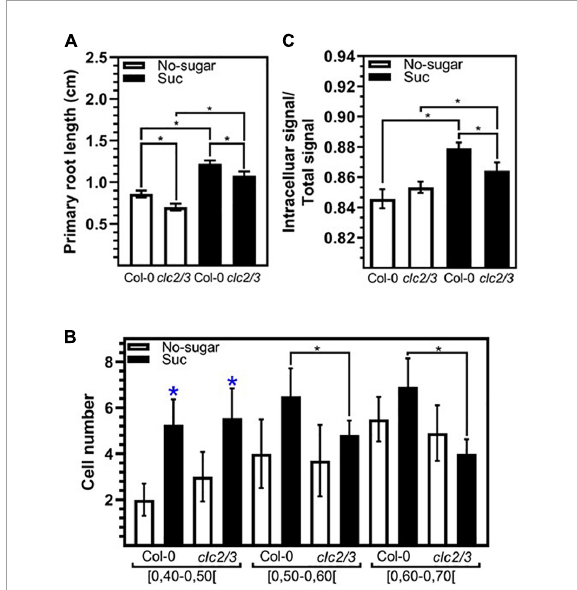
FIGURE5 The function of CLC2 and CLC3 are required for sucrose induced endocytosis and cell elongation. Arabidopsis wild-type (Col-0) and clc2-1 clc3-1 ( clc2/3 ) seedlings were sown on sugar-free (No-sugar) or 60 mM sucrose-supplemented (Suc) solid medium and grown for 7 days. (A) Primary root length of seedlings was measured in n ≥ 20 seedlings per replicate. (B) Cell height and width were measured for epidermal cells on the meristematic zone (ratio height/width ≤ 1) of the seedling primary root. The number of cells that display a range of a cell elongation index is shown. n ≥ 15 seedlings were scored in either condition. (C) Endocytosis of FM4-64 was evaluated by confocal imaging of epidermal cells after 15 min of FM4-64 plasma membrane labeling. About 15 seedlings were evaluated for either condition in experimental triplicates. FM4-64 was quantified at the intracellular and whole-cell. Results are expressed as the ratio between both values. (A–C) Error bars represent standard error for three independent biological replicates. (A,B) Student’s t -test; * p < 0.001. (C) Two-tailed-Student’s t -test; * p < 0.05. Blue asterisks indicate statistical differences between no-sugar and sucrose condition for each